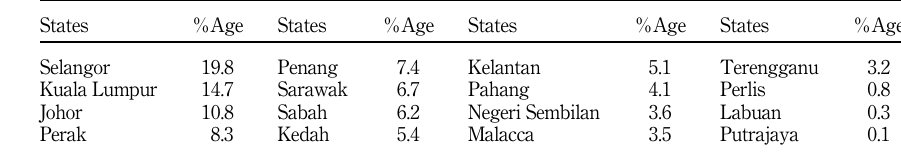
Table 2. SMEs in Malaysian